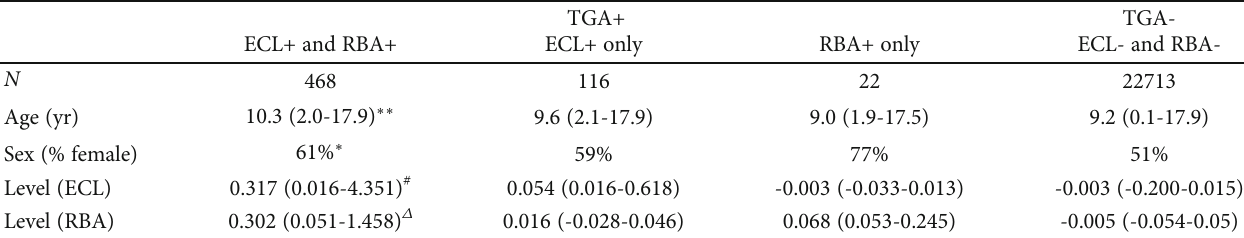
Table 1: Demographic data and TGA levels of the children screened.